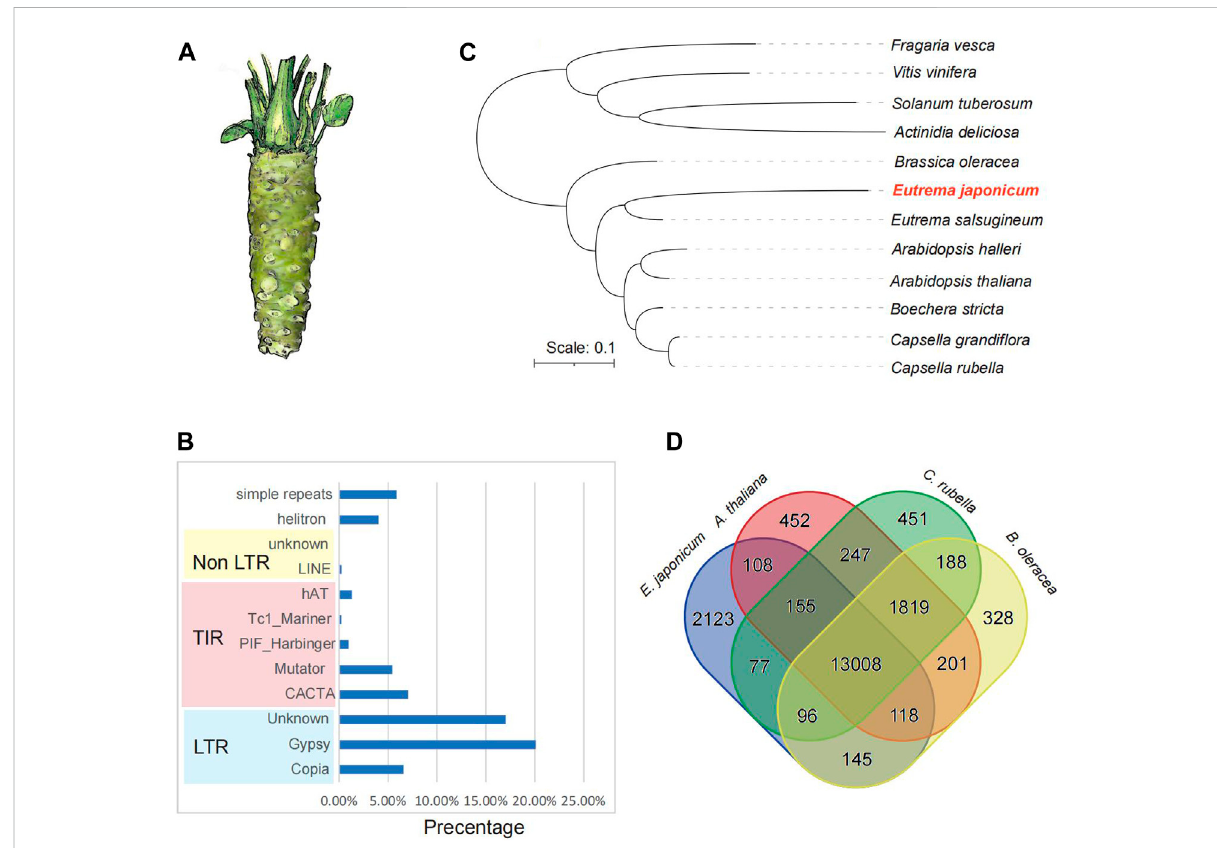
FIGURE 1 The genome assembly of wasabi ( Eutrema japoniacum ). (A) The morphology of the wasabi. (B) The statistics of repetitive sequence across the genome. (C) The phylogenetic tree of 12 representative species was constructed using the single-copy genes. (D) Veen diagram of orthologous groups from the four representative species: Eutrema japoniacum , Arabidopsis thaliana , Brassica oleracea, and Capsella rubella